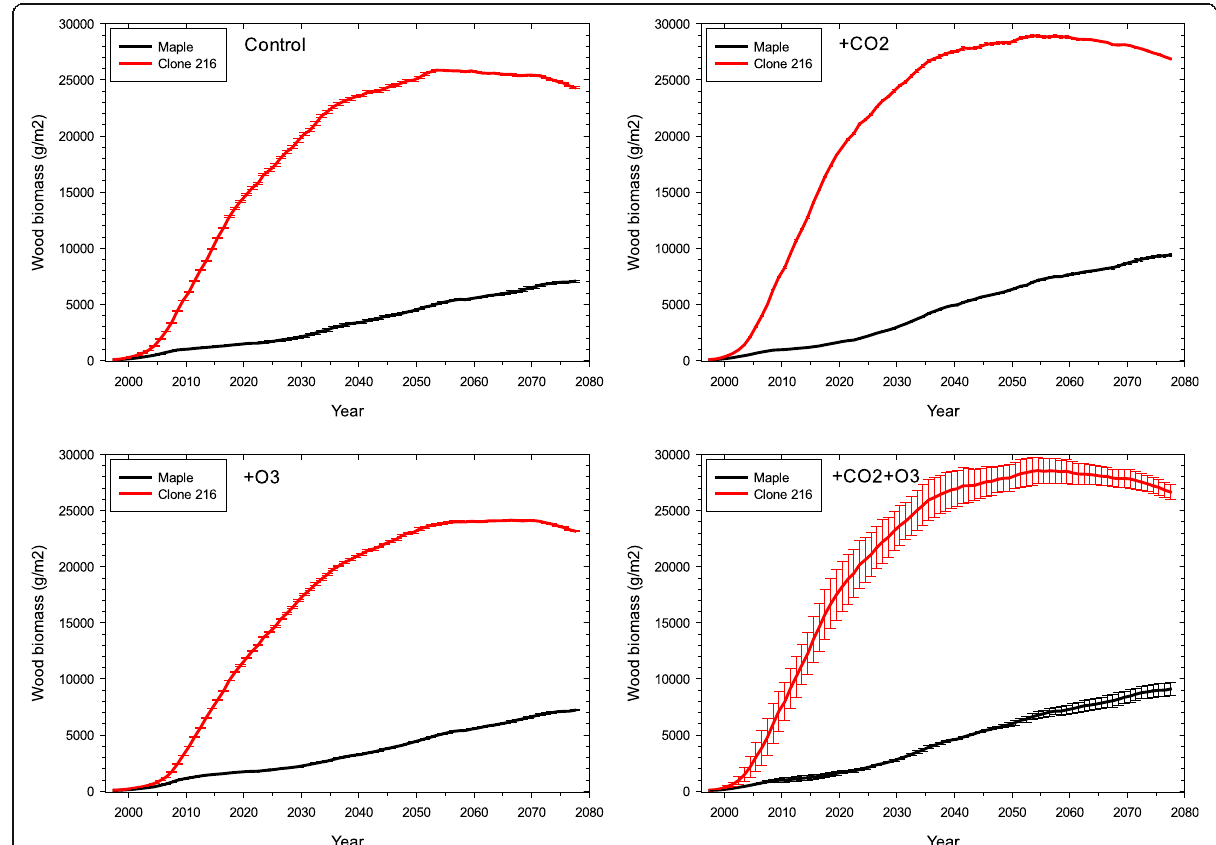
Fig. 7 Extrapolation by simulation 80 years into the future of the maple-aspen Section of the Aspen-FACE experiment. Error bars show one standard deviation of three